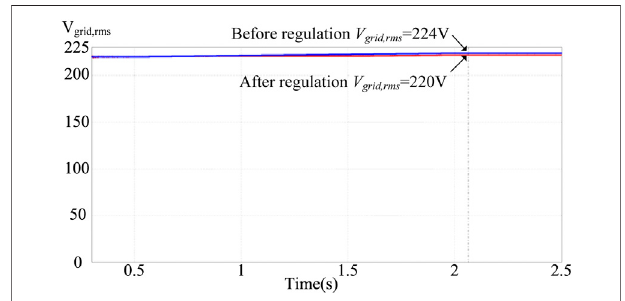
FIGURE11 | When thegrid voltage per unit value isbetween 1and 1.03 p.u., the unregulated grid voltage value V grid and the regulated grid voltage value V grid .